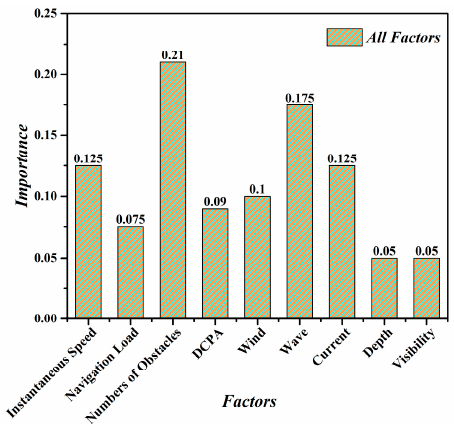
Figure 8. Factor importance after normalization.